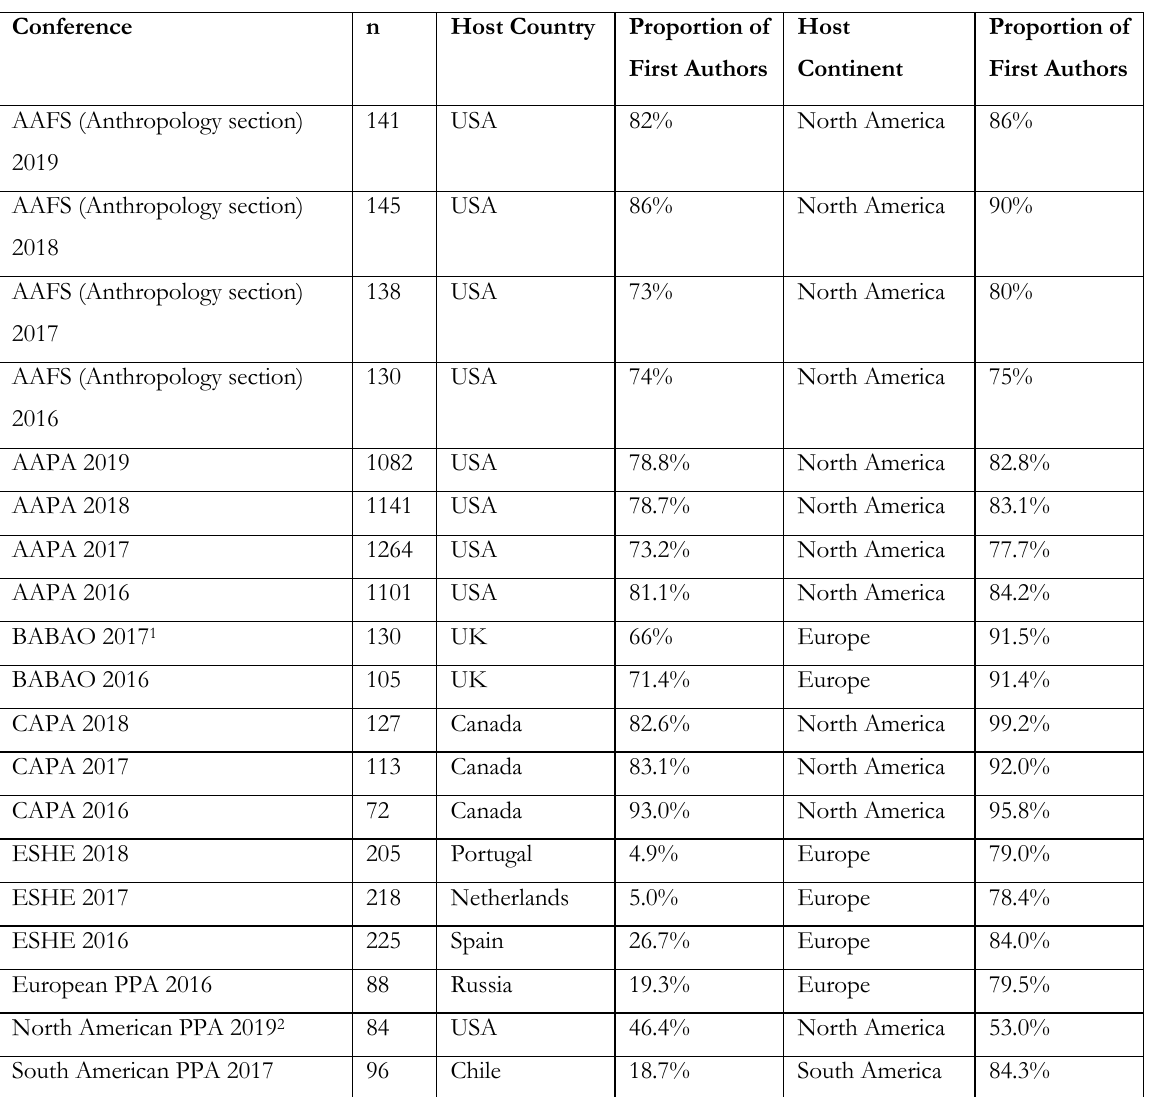
Table 2 : Proportion of first author presenters from the host country and continent for several major biological anthropology and bioarchaeology conferences. Data from